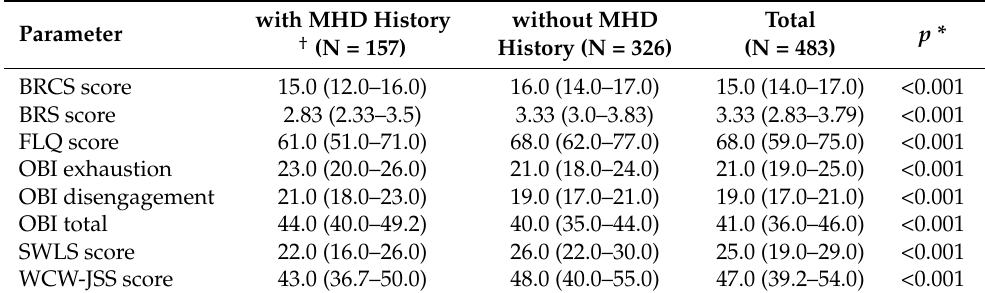
Table 4. Total scores of used questionnaires investigating burnout levels, resilience, satisfaction with life and job, and healthy lifestyle in family physicians according to the history of mental health disorders.